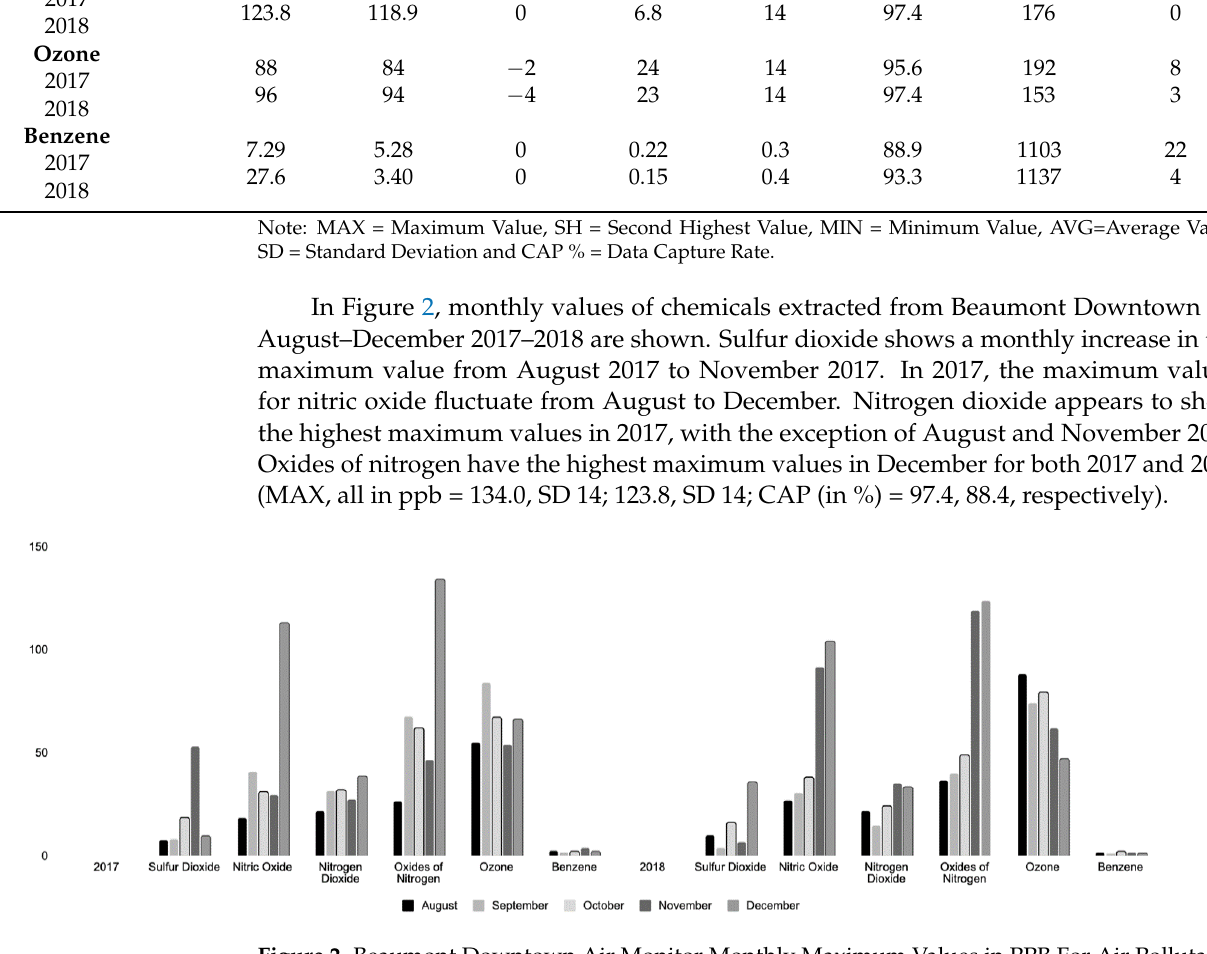
Table 1. Yearly values 2017 – 2018 chemicals measured at air monitor Beaumont Downtown average values appear relatively similar from 2017 to 2018. In 2017, we identified 68 days of missing data for all chemicals and 22 days missing data for benzene. MAX SH MIN AVG